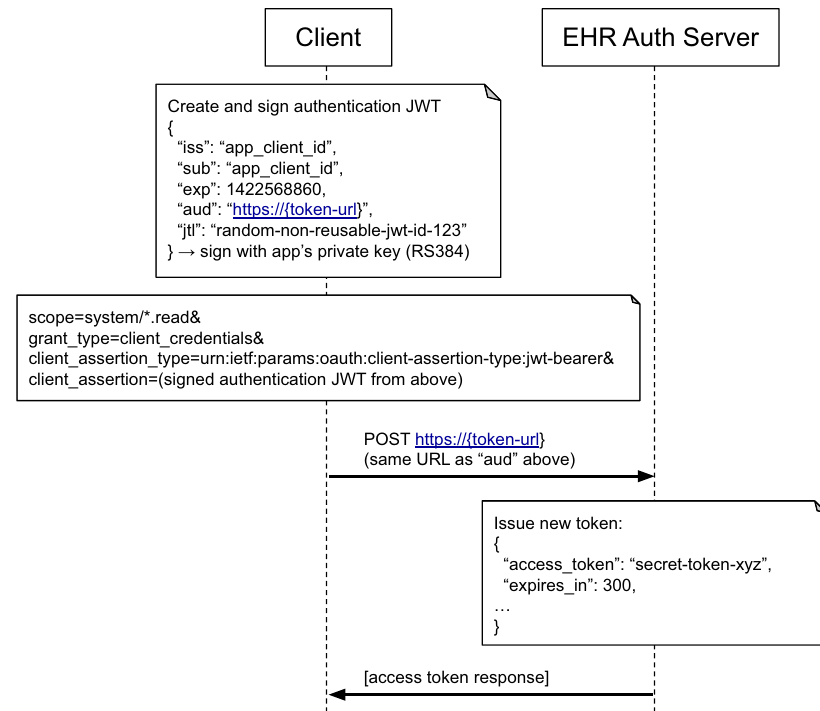
Fig. 2 SMART Backend Service Authorization Work fl ow. An authentication JWT is posted to an EHR authorization server, which responds with an access